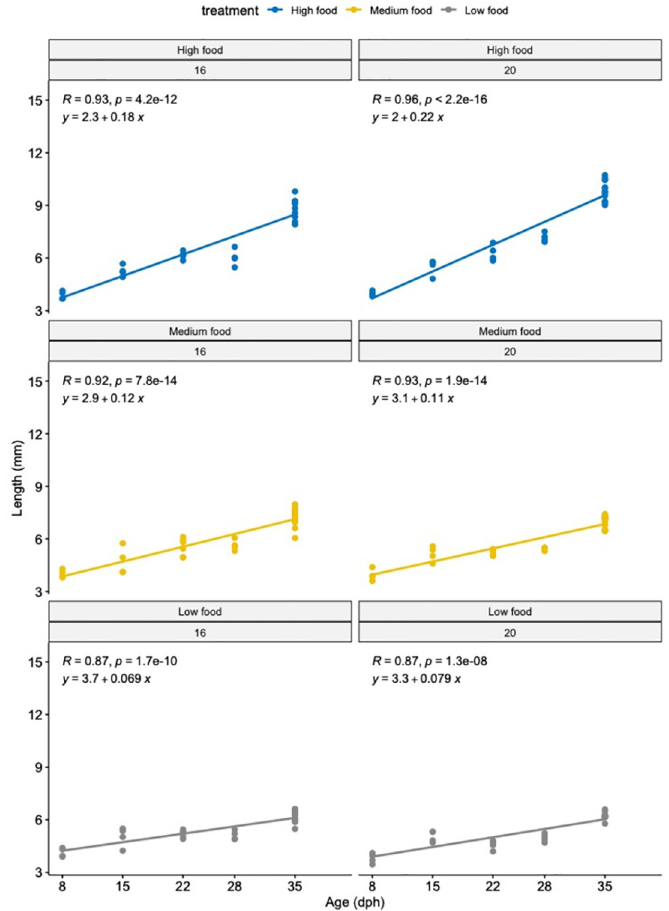
and low (grey) feeding frequencies.